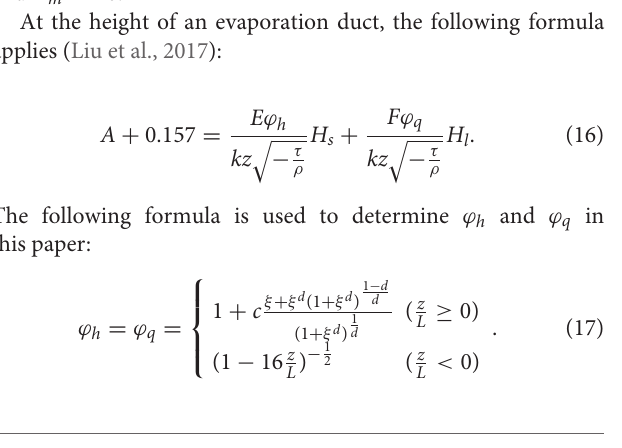
TABLE 4 | The eight categories divided according to the values of R ib , z / z 0 and z / z 0 t . Region R